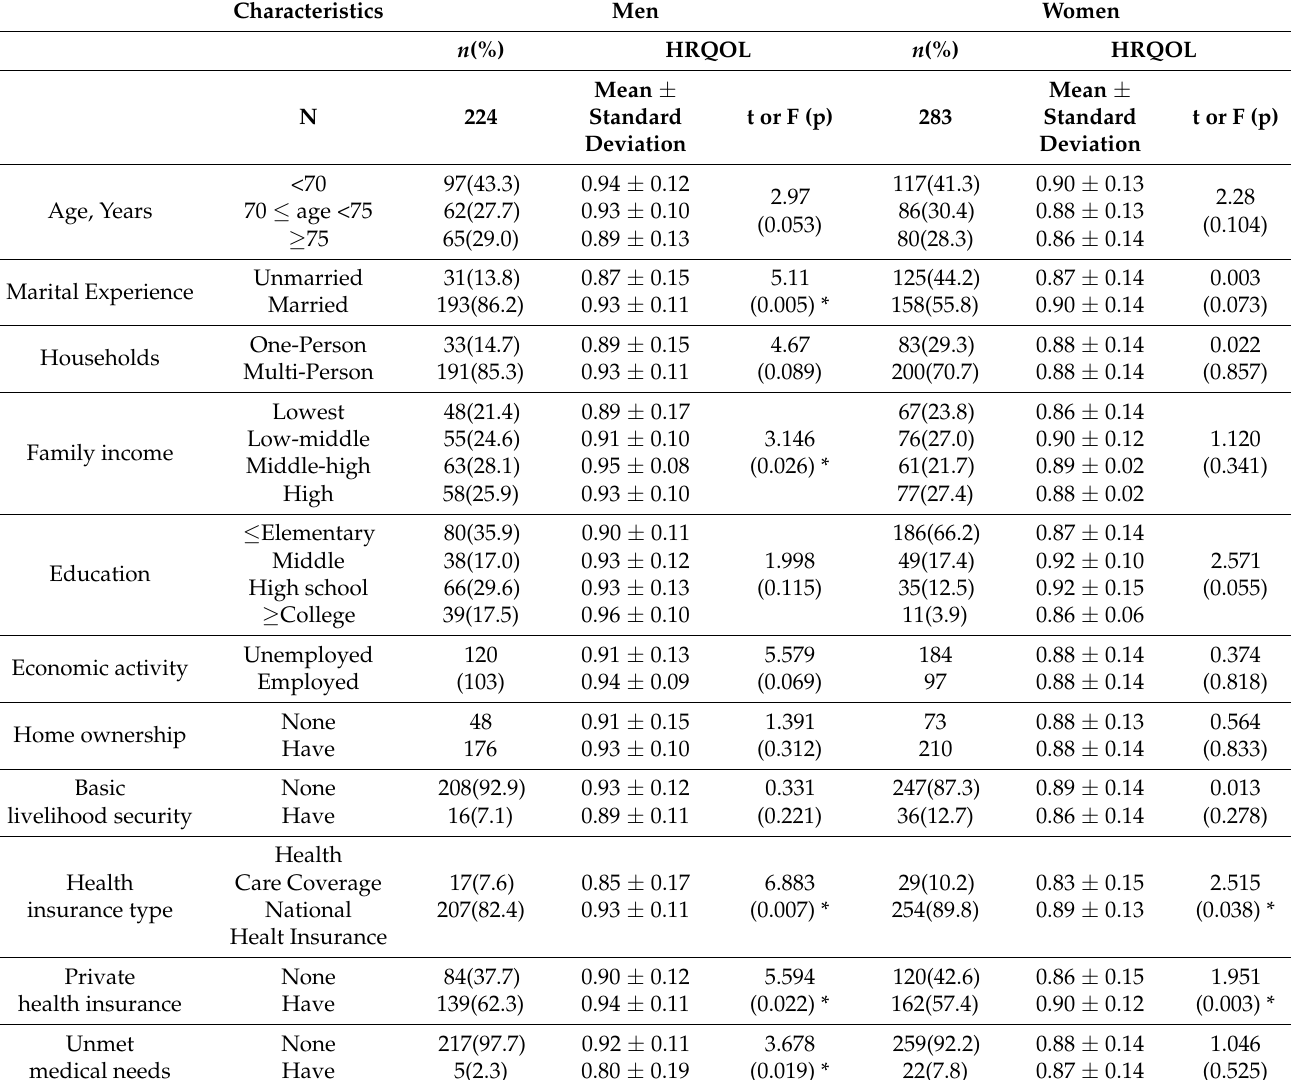
Table 1. Difference in health-related quality of life by demographic and socioeconomic factors.